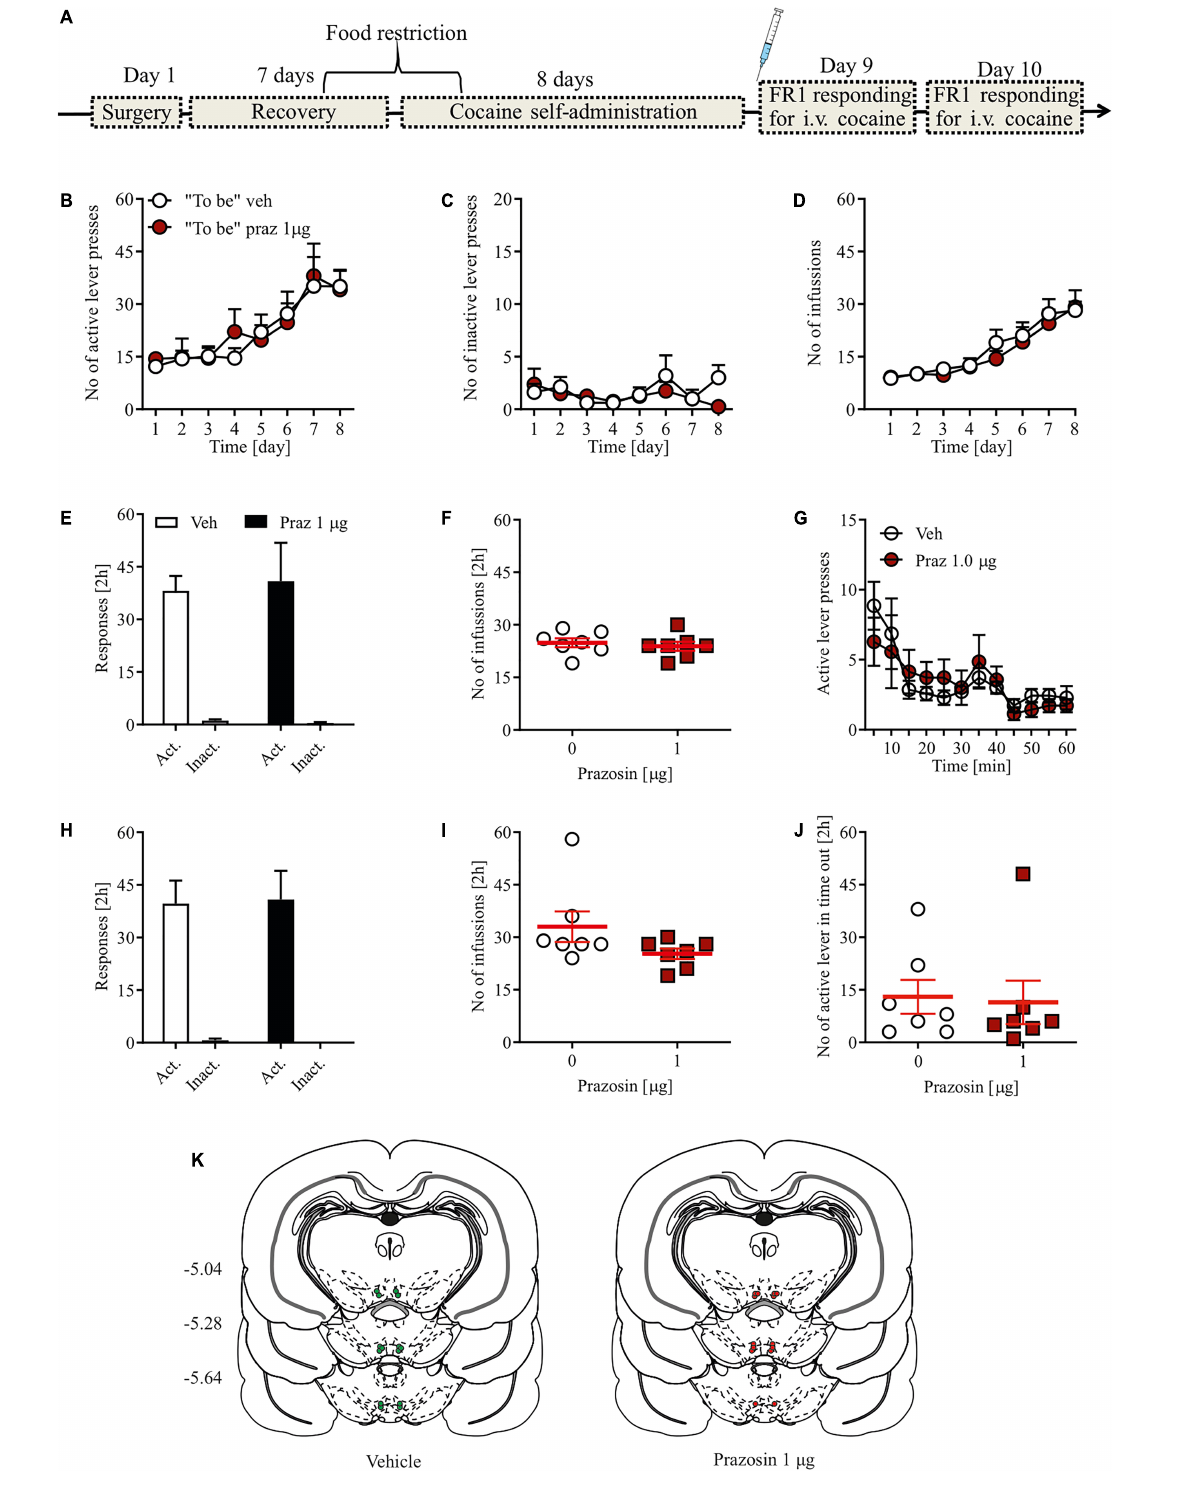
FIGURE2 Effects of α 1 -AR blockade in the VTA on cocaine reinforcement in the cocaine self-administration paradigm. (A) Rats, after intravenous catheter and intra-VTA cannula implantation surgeries and recovery were trained to self-administer cocaine ( ∼ 0.5 mg/kg/inf.) for 8 days. On day 9, intra-VTA vehicle (Veh) or prazosin (Praz) microinfusions were performed immediately prior to subsequent cocaine self-administration session. (B–D) There were no pre-existing differences during cocaine self-administration training in the number of (B) active and (C) inactive